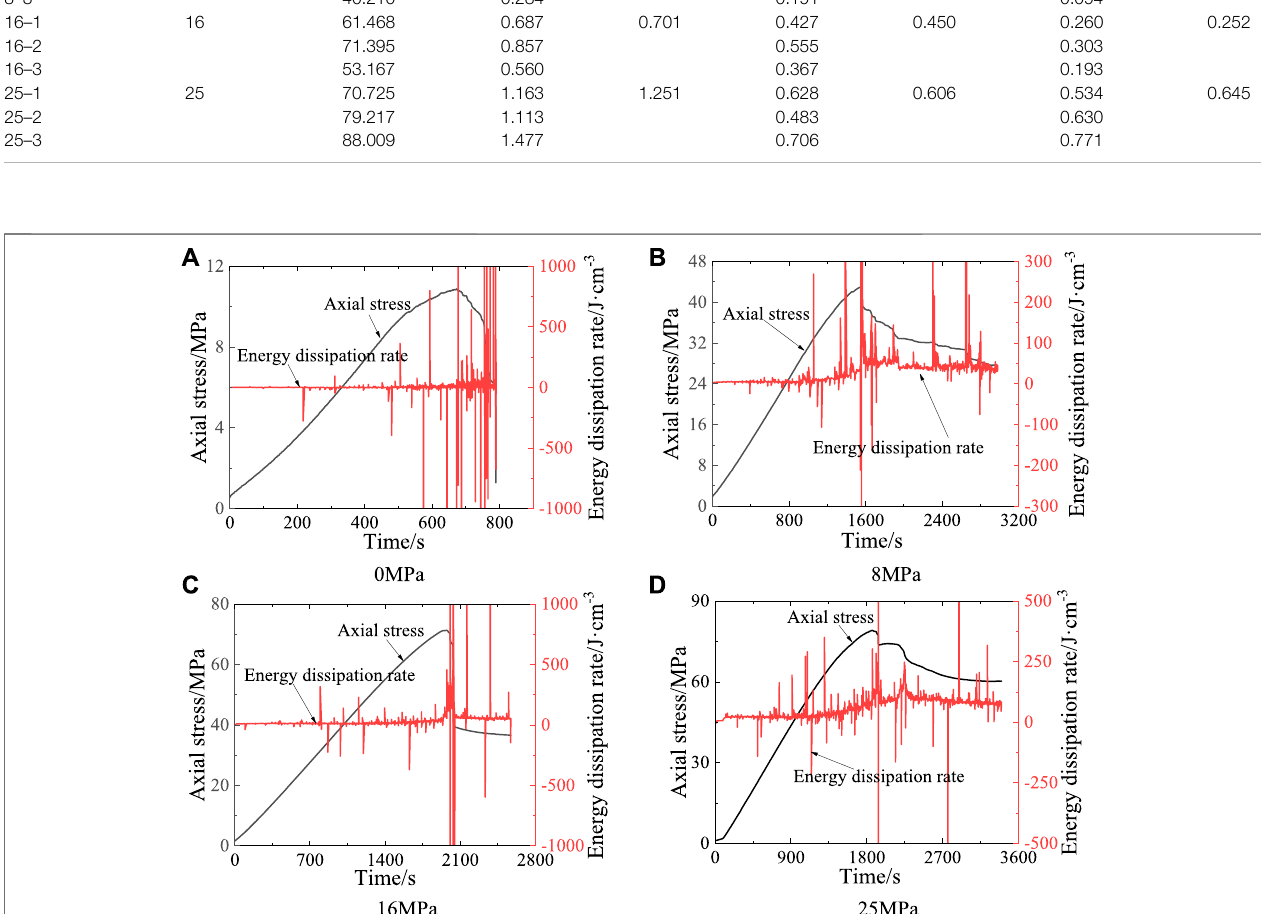
FIGURE 8 | Energy dissipation rate of coal rock under different con fi ning pressures. (A) 0 MPa, (B) 8 MPa, (C) 16 MPa, (D) 25 MPa.